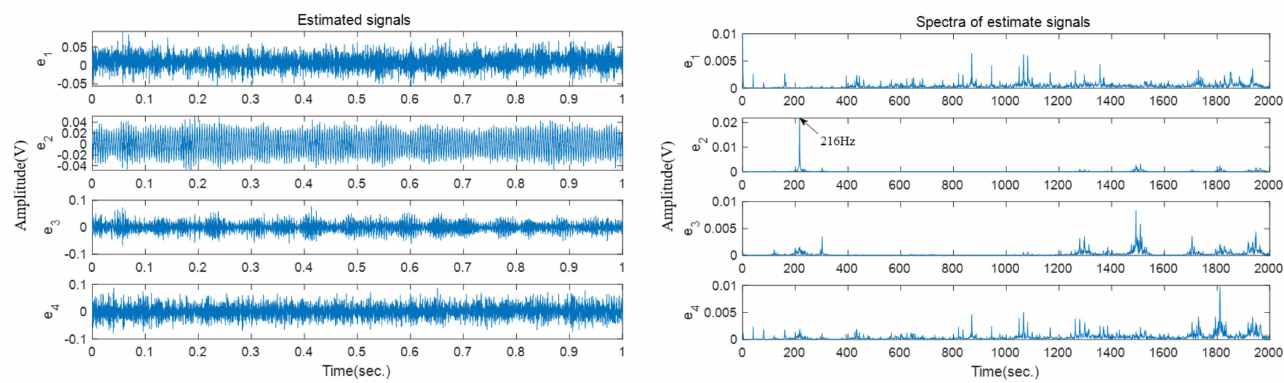
Figure 15. Time − domain waveforms and frequency spectra of the four recovered